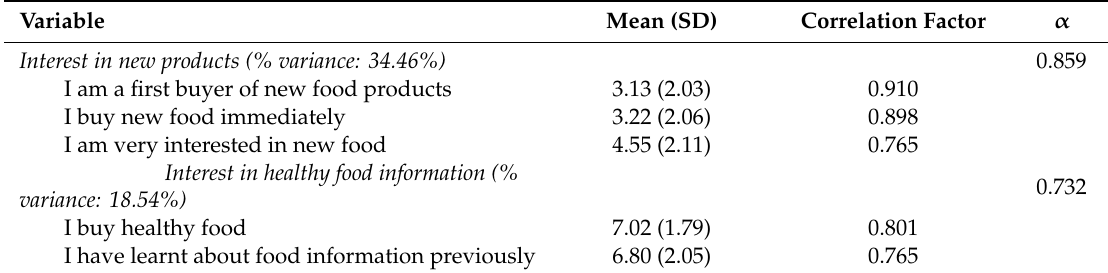
Table A2. Factor analysis of attitude towards innovation and food